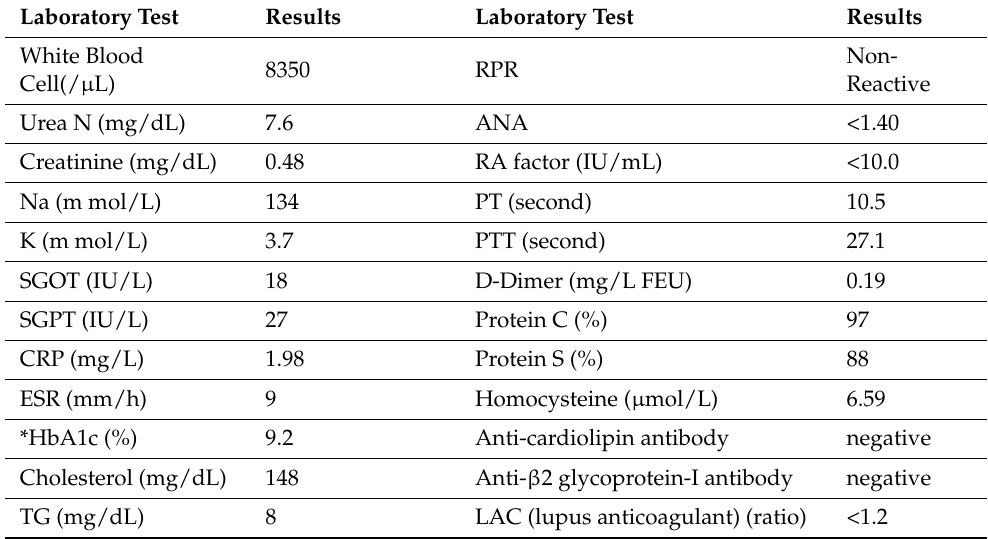
Table 1. Clinical laboratory results of the patient. Except for HbA1c*, other data were negative or within normal